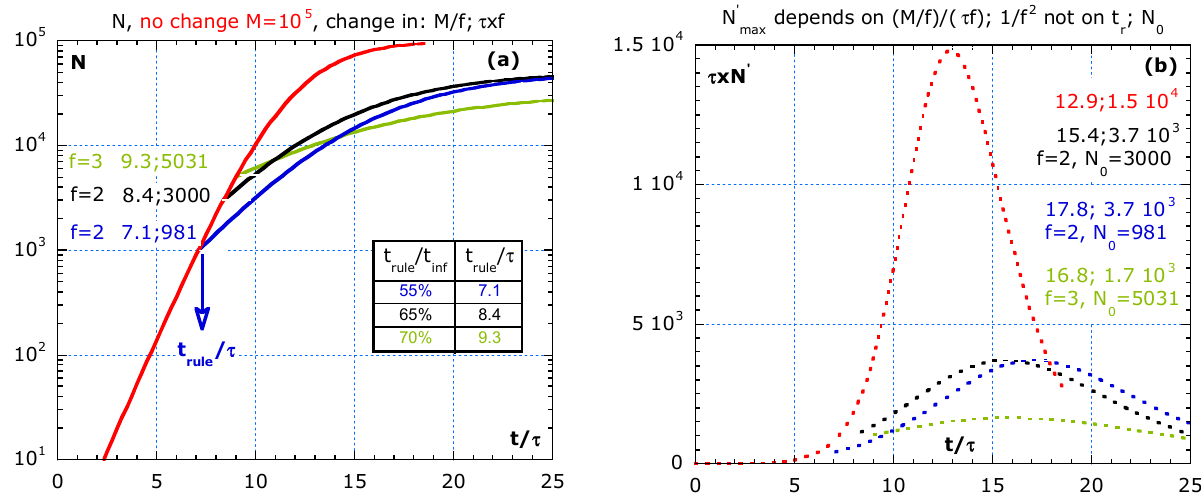
Figure 6. The effect of imposing stronger rules (or a very effective 66.6% vaccination degree) at different times during the process assuming: M new = M / f ; τ new = τ × f and f > 1 are compared to no change in red lines. Time lag is not considered. ( a ) The cumulative number, N, at the introduction of the rules, the values: t rule / τ ;N 0 . ( b ) The flattening of the epidemic curve (multiplied by τ ) of the scenarios in ( a ) with the normalized time at the maxima, t max / τ , its normalized value . N max , the f-value and N 0 .